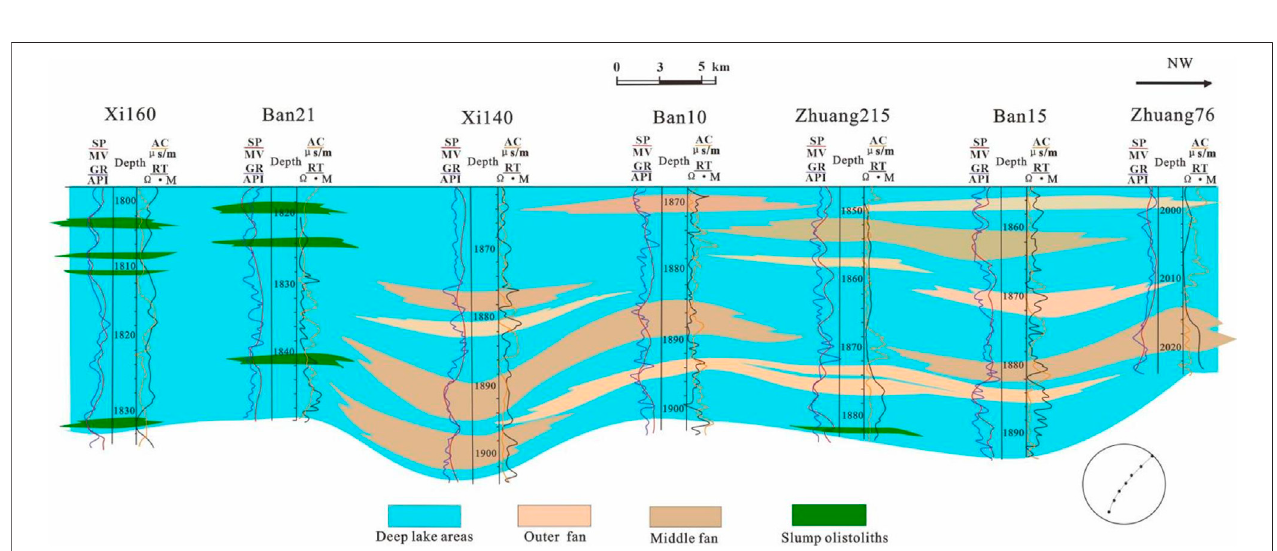
FIGURE 10 | Interwell sedimentary facies correlation. Well Xi160-well Ban21-well Xi140-well Ban10-well Zhuang215-well Ban15-well Zhuang76. See Figure 2 for the location of the line of interwell correlation.